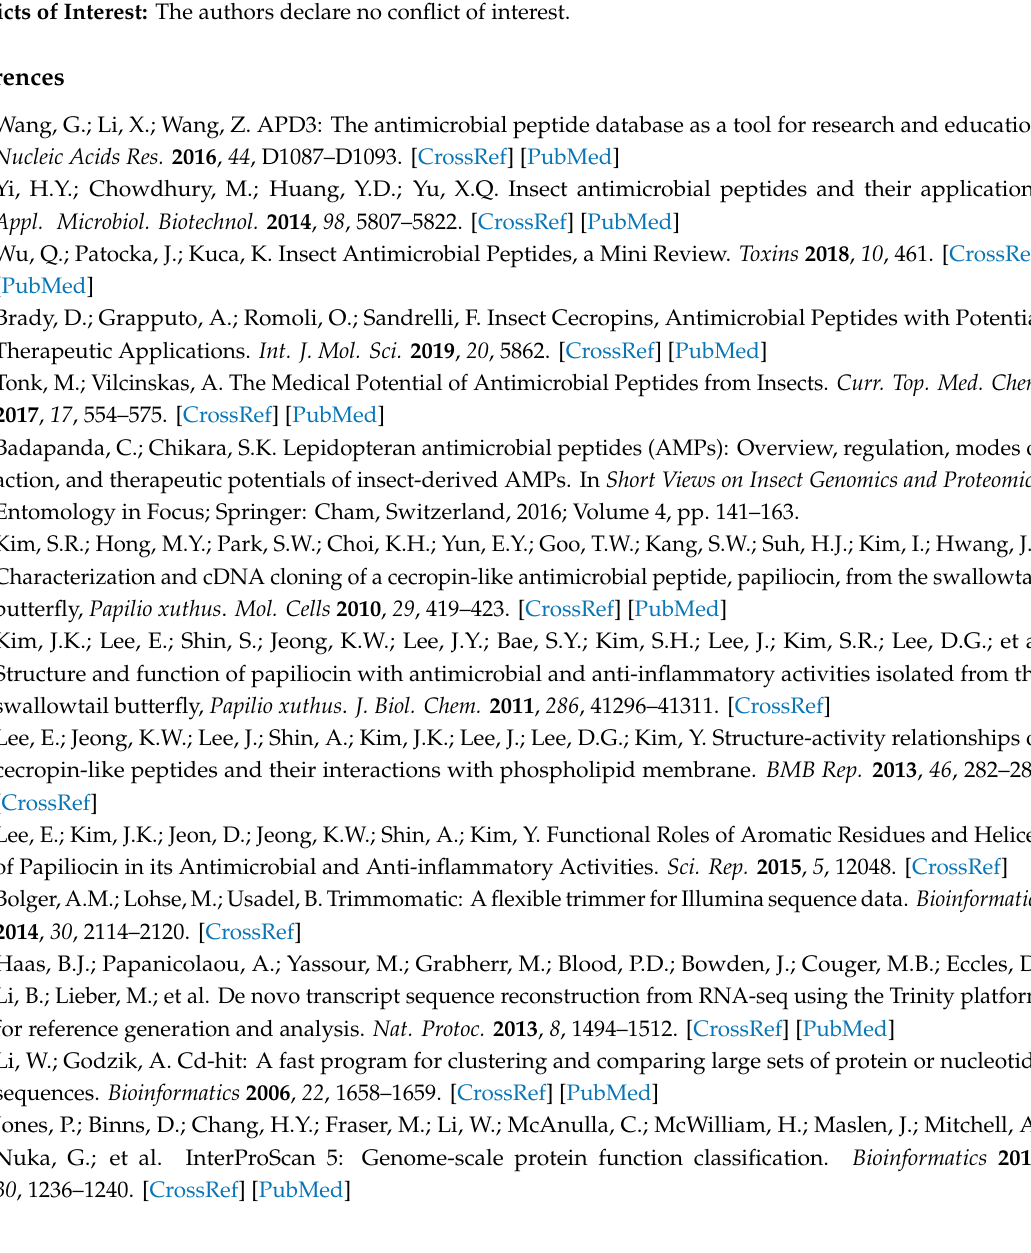
Table S1: Summary of sequencing and annotation, Table S2: Antimicrobial peptide properties prediction and